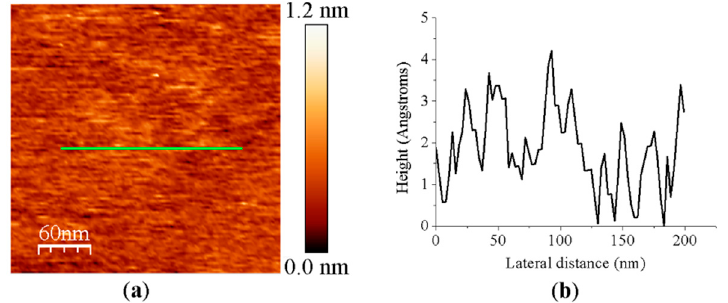
Figure A1. ( a ) Representative AFM image of the muscovite mica sheet surface used in this study. Scan size is 300 nm × 300 nm. ( b ) Height profile corresponding to the green line displayed on the AFM image.